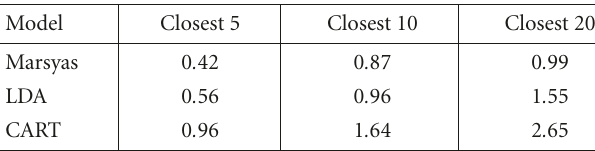
Table 6: Average number of closest songs occurring on the same